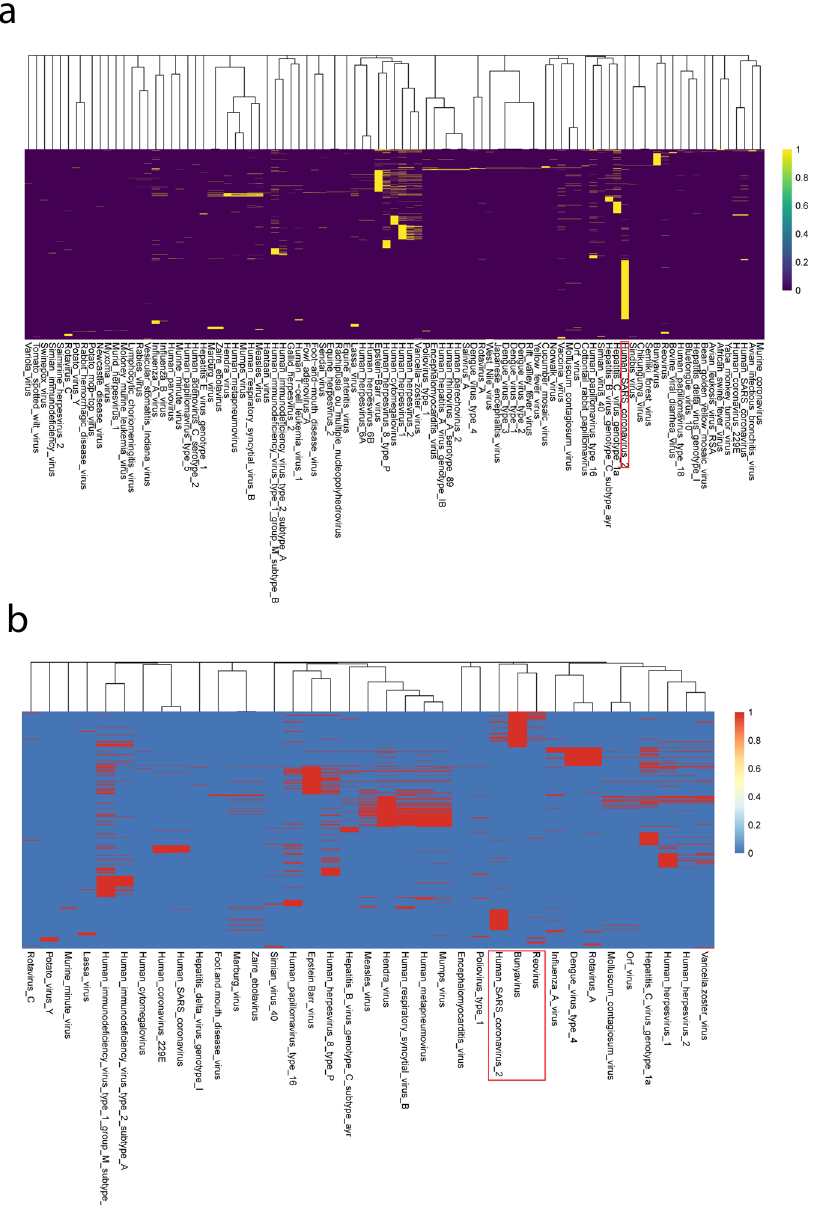
Fig. 5 Clustering analysis based on the viruses ’ fi rst range human protein targets and their related enriched Reactome pathways. Viruses are clustered based on their ( a ) shared human protein direct targets ( fi rst range interactors) and ( b ) the enriched Reactome pathways containing these proteins. Binary distance has been used to perform the hierarchical clustering in all subplots. Red boxes highlight the cluster containing SARS-CoV-2. Enrichment analyses were performed with the R package clusterPro fi ler 50 with a cutoff of p value <0.005. Viruses for which we could not fi nd any enriched Reactome pathway do not appear on the enrichment heatmaps. Complete results of these enrichment analyses are available as Supplementary material (Supplementary Data 1 and